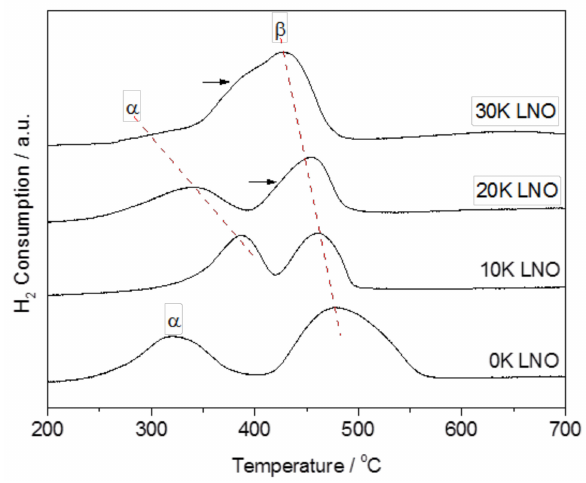
Figure 2. H 2 TPR profiles of the 0–30K LNO